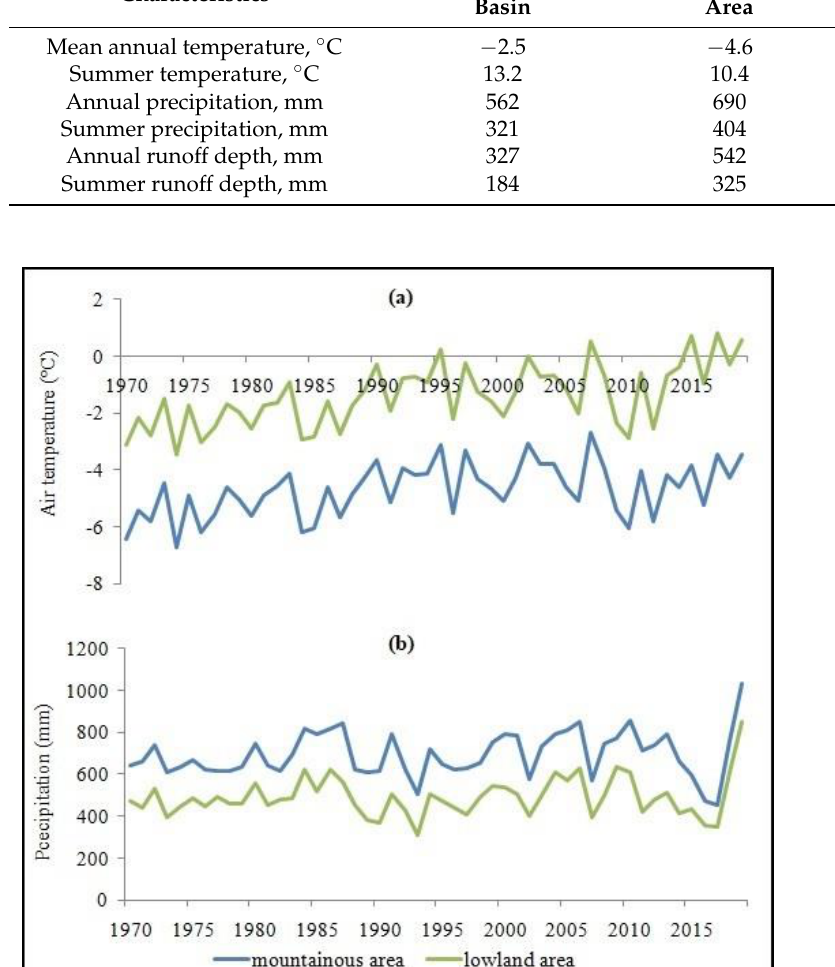
Figure 3. Interannual dynamics of air temperature ( a ) and precipitation ( b ) in the mountainous and lowland parts of the Iya River basin over the period 1970–2019. lowland parts of the Iya River basin over the period